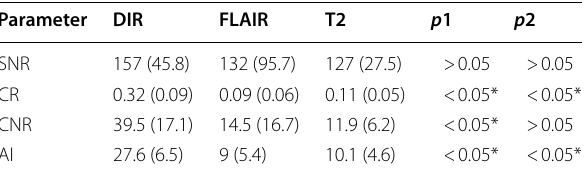
Table 3 contrast measurements in patients with focal cortical dysplasia compared between DIR, FLAIR, and T2 MRI (Data are presented as means (SDs))